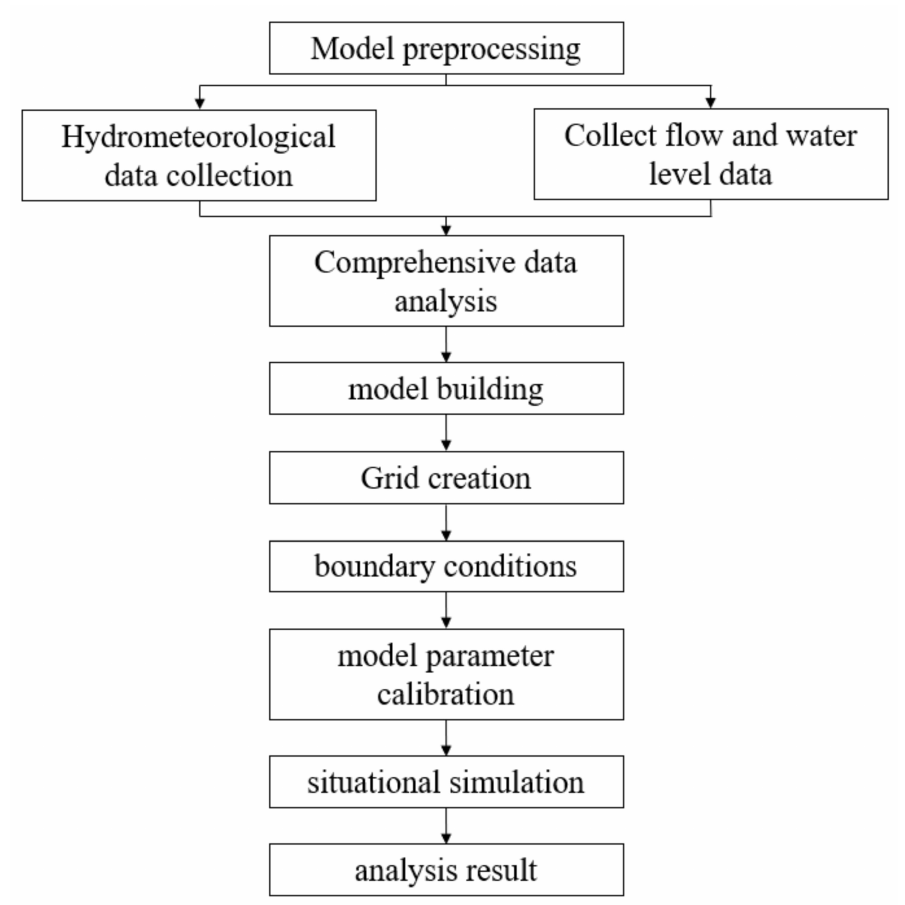
Figure 3. Flow chart of Taipu River oil spill model